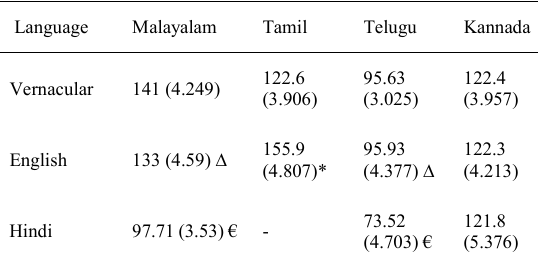
Table-2. Word processing rate (SEM) in different languages presented in No. of